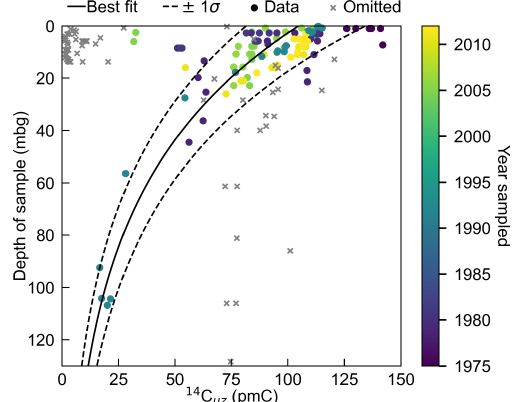
Figure 2. Relationship between pmC in the unsaturated zone ( 14 C uz ) and depth below the surface for sedimentary basins. Data points omitted from the fitting process (grey crosses) were omitted due to the presence of high organic matter, deep-rooted vegetation, or where gasses were influenced by the advection of modern air into the unsaturated